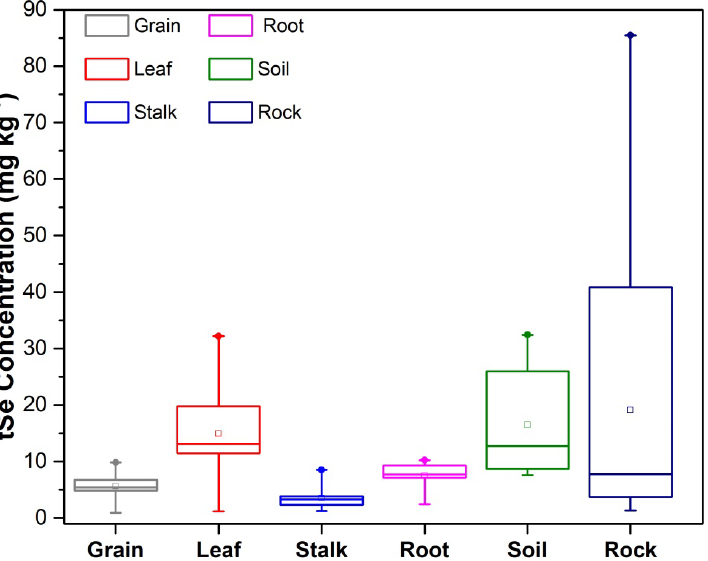
Figure 3. Total Se concentrations in grain, leaf, stalk, root, soil, and rocks for (n = 11) samples in triplicate. The squares are the mean values. The limits represent the minimum and maximum values, and the horizontal bottoms, middles, and top lines correspond to the 10th percentile, median, and 90th percentile values, respectively.